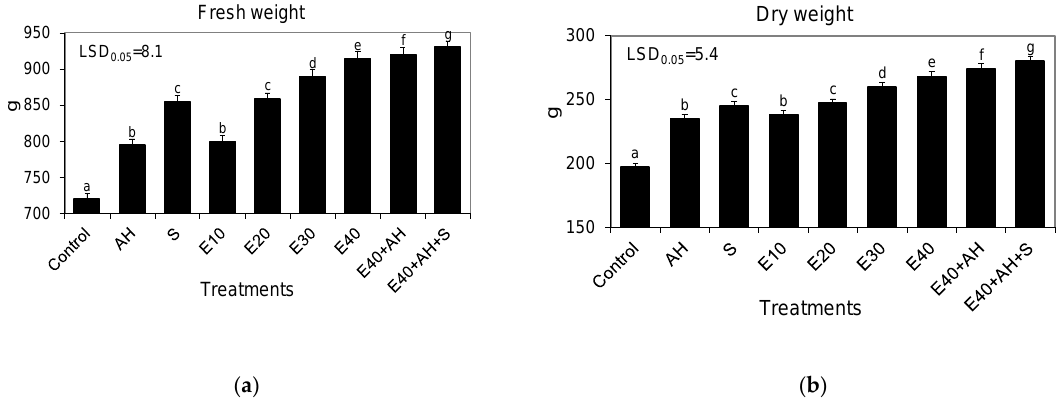
Figure 2. Fresh ( a ) and dry biomass ( b ) of one Jerusalem artichoke plant cultivated in a field and fertilized with liquid non-centrifuged waste from corn grain digestion to methane (E10, 40 m 3 ha −1 ), Apol-humus (AH; 10 L ha −1 ), and Stymjod (S; 5 L ha −1 ). The data marked with the same letters are not significantly different, according to the Newman–Keuls multiple range test at an alpha level of 0.05. The data presented are the average over the years and five plants in each repetition of a particular experimental variant.